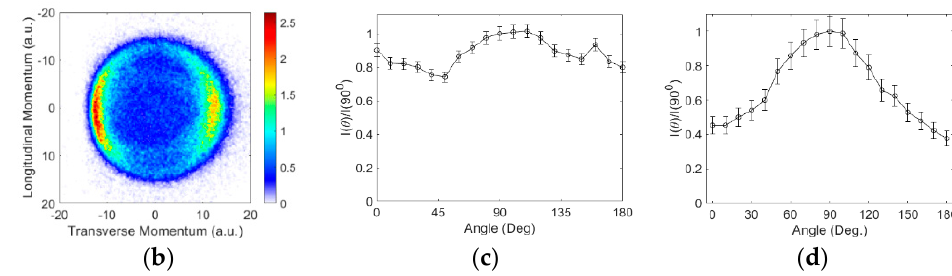
Figure 3. Momentum images obtained for the H − ions from ( a ) aniline at 4.7 eV and ( b ) benzylamine at 5.5 eV. The incoming electron beam direction is from top to bottom; ( c , d ) are the respective angular distributions.